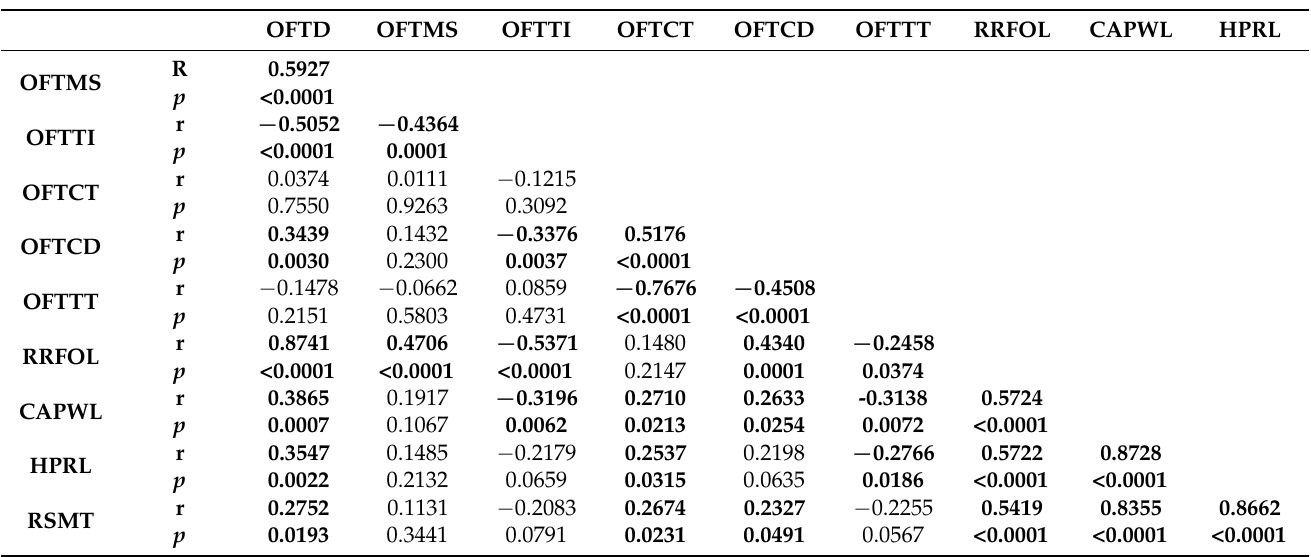
Table 1. Pearson’s correlation matrix (correlation coefficient “r” and two-tailed p -value) between measured behavioral variables.